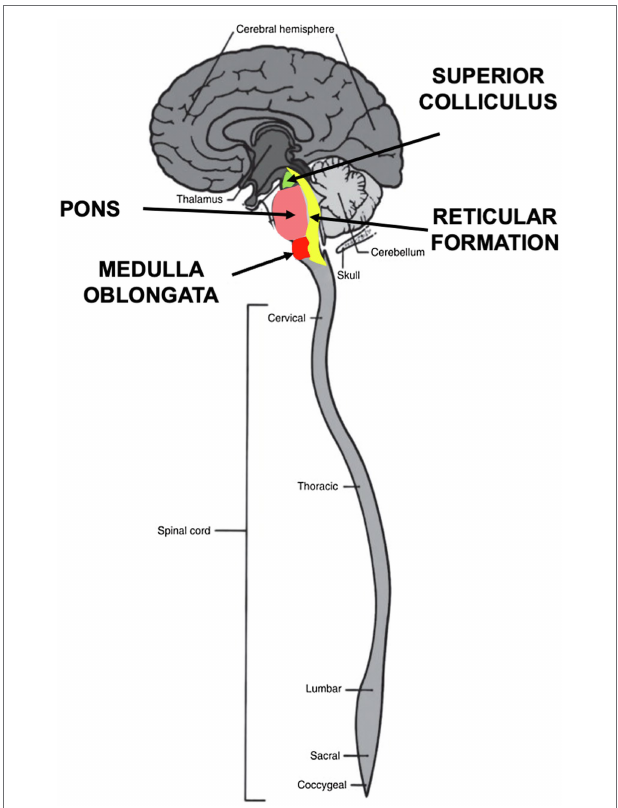
FIGURE 4 | Brainstem nuclei involved in orienting behaviors . Four nuclei in the brainstem process sensory stimuli during orienting. The superior colliculus in the midbrain integrates visual, auditory and somatosensory signals to initiate motor commands. The pons relays sensory information to the medulla and cerebellum. The medulla oblongata controls autonomic activities, such as heartbeat and respiration and transmits sensory signals between the spinal cord and the higher parts of the brain. The reticular formation functions as a “first alert” system to arouse and react by means of the reticular activating system